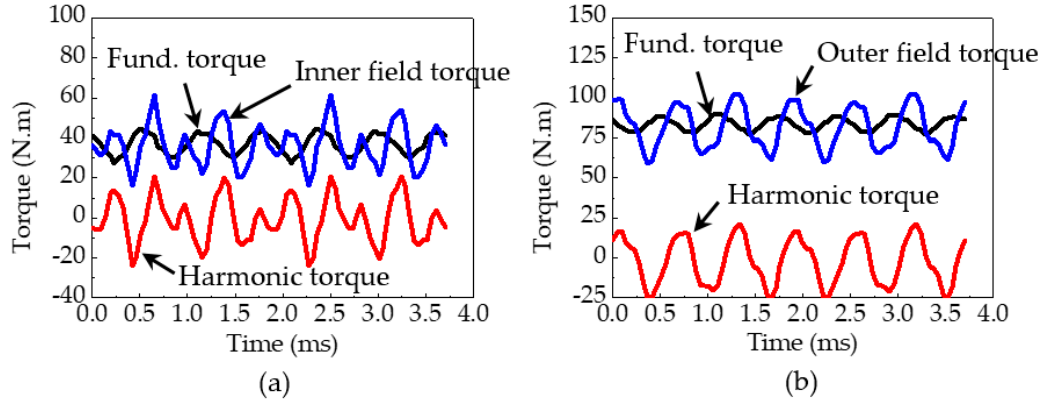
Figure 13. Torque contribution of the fundamental component torque and the harmonic torque when the output rotor operated at 1246 rpm ( f inner = 270 Hz, f outer = 0 Hz): ( a ) Inner field torque; ( b ) Outer field torque.